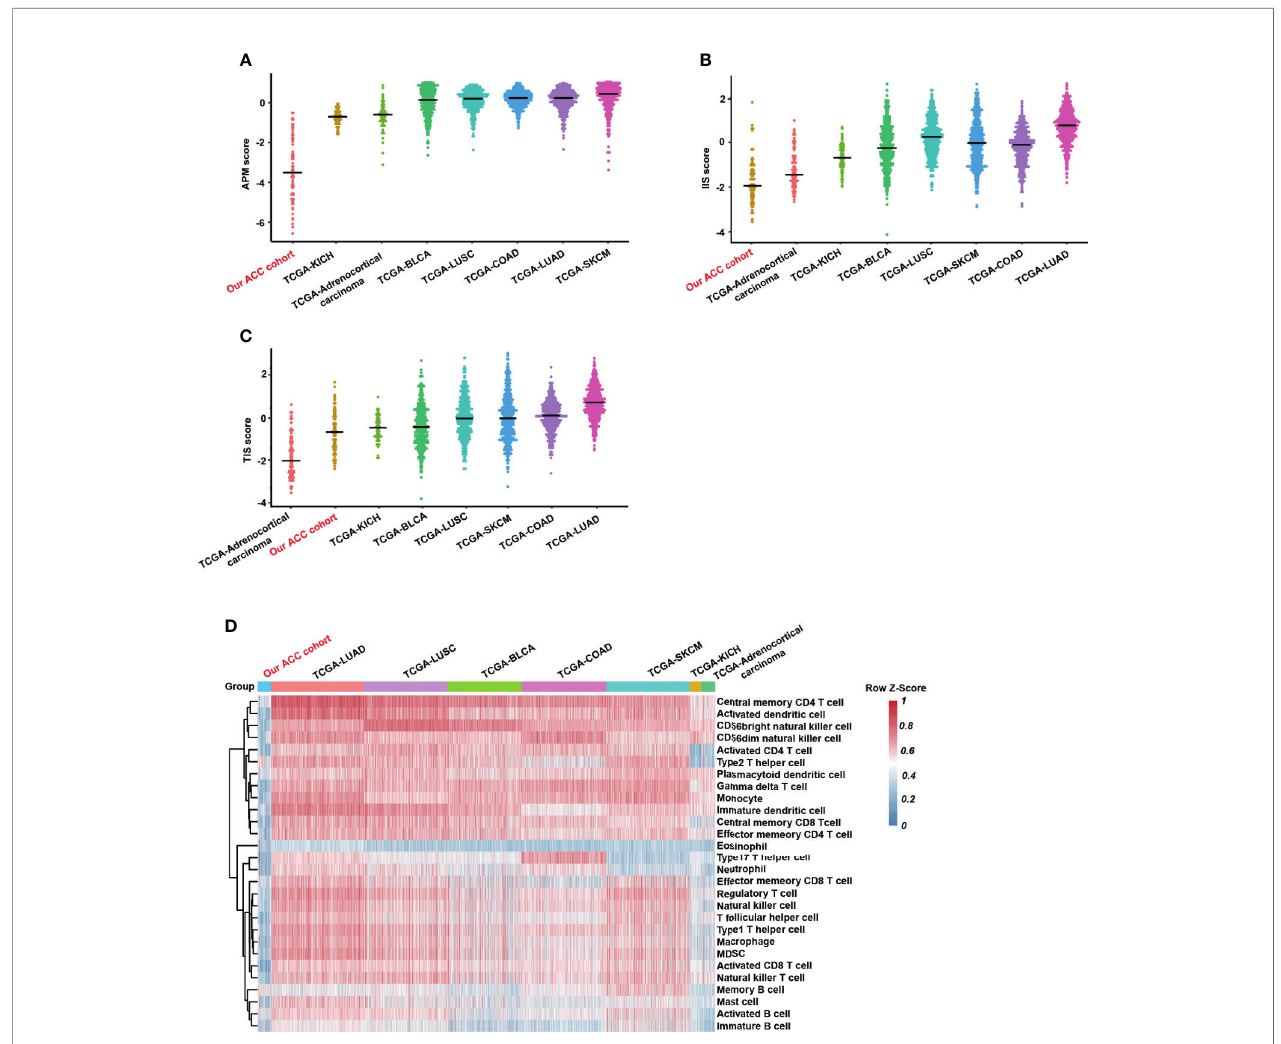
FIGURE 3 | APM, immune in fi ltration, T cell in fi ltration, and immune cells in our ACC cohort compared with seven TCGA cohorts. (A) Antigen-presenting machinery (APM) score in eight tumor types. Each dot represents an individual tumor sample. Tumor types are ordered from left to right according to increasing median APM (medians indicated by horizontal black bars). (B) Overall immune in fi ltration score (IIS) for eight tumor types. Tumor types are ordered from left to right according to increasing median IIS (medians indicated by horizontal black bars). (C) T-cell in fi ltration score (TIS) in eight tumor types. Tumor types are ordered from left to right according to increasing median TIS (medians indicated by horizontal black bars). Immune cell Score estimated by ssGSEA for our cohort compared with adrenocortical carcinoma, BLCA, COAD, KICH, LUSC, LUAD, and SKCM TCGA samples, representing overall immune in fi ltration, based on gene level normalized count of respective RNA-Seq data. (D) Unsupervised clustering patients from our ACC cohort and 7 TCGA cohorts using ssGSEA scores from 28 immune cell types. ACC, adenoid cystic carcinoma; BLCA, urothelial bladder carcinoma; COAD, colon adenocarcinoma; KICH, kidney chromophobe; LUSC, lung squamous cell carcinoma; LUAD, lung adenocarcinoma; SKCM, skin cutaneous